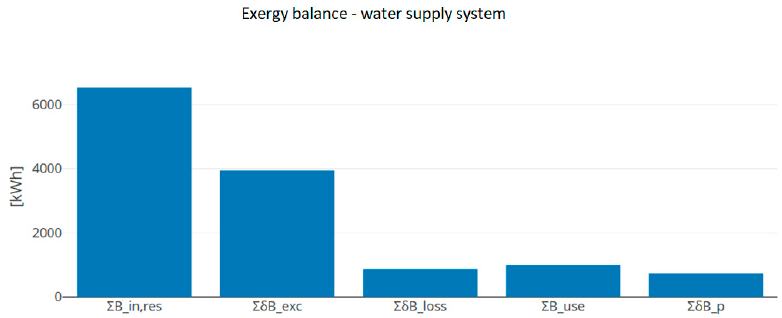
Figure 10. Exergy balance chart for analysed water-supply system.